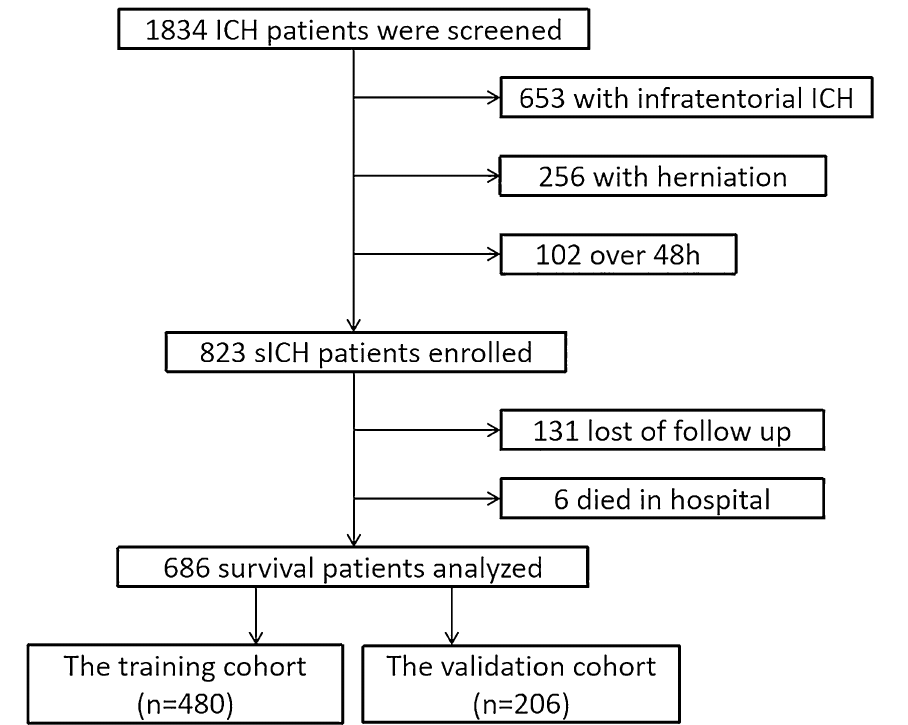
Figure 1. The screening flow chart of the study